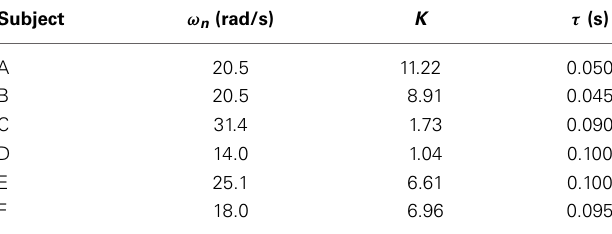
FIGURE 7 | Modeled (A) magnitude plot and (B) phase plot. Table 2 | Parameter values for the six subjects.